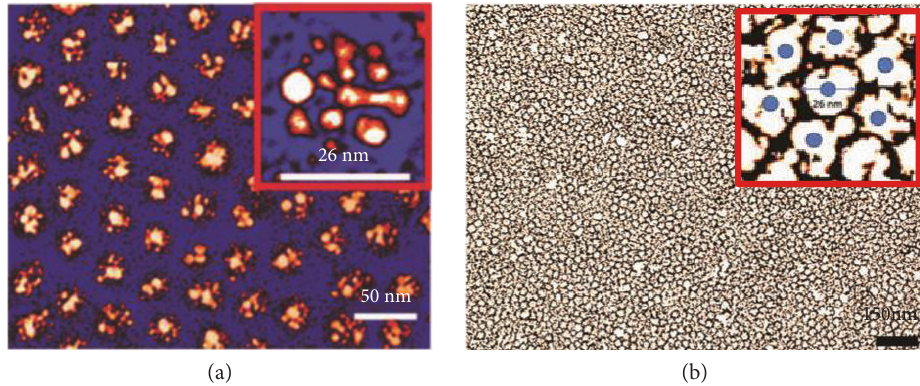
Figure 2: Characterization of the SERS substrate. (a) TEM micrograph of hexagonal nanostructure obtained following the procedure described in [25]. The inset shows, in detail, a single cluster of Ag-NPs. (b) TEM micrograph of the pattern obtained by applying our implemented protocol. The fi lling fraction is highly increased reducing nanoisland gaps to 2-3 nm, as shown in the inset. Bar scales are 50 nm in (a) and 150nm in (b). Bar scale in the inset in (a) is 26nm. (Adapted from [37] with permission from the Royal Society of Chemistry.)